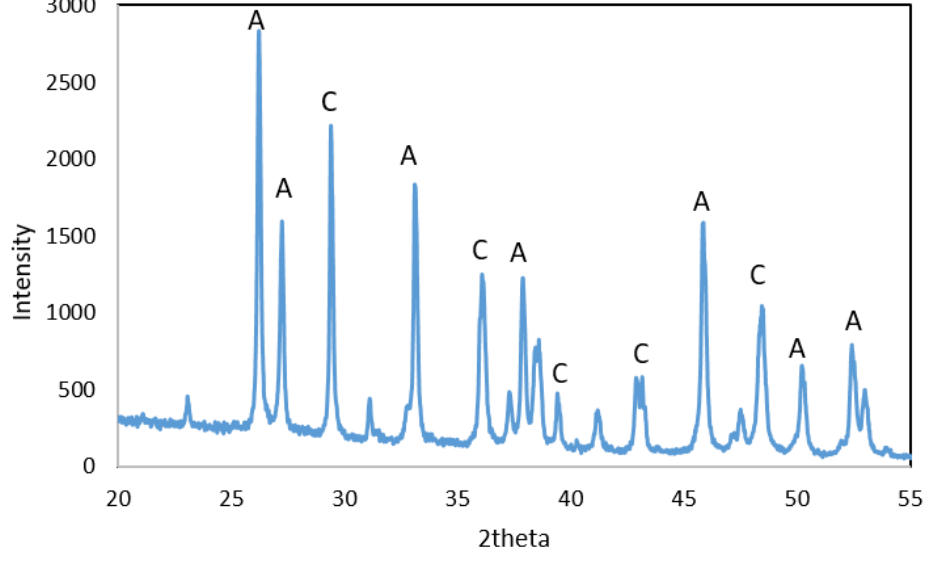
Figure 2. XRD diffractogram of WS: A—aragonite and C—calcite. The SEM image shows that WS had large, elongated crystals with a smooth surface, along with small crystals which had a higher roughness. The EDAX spectra indicated that this adsorbent was primarily composed of C, O and Ca (Figure 3).